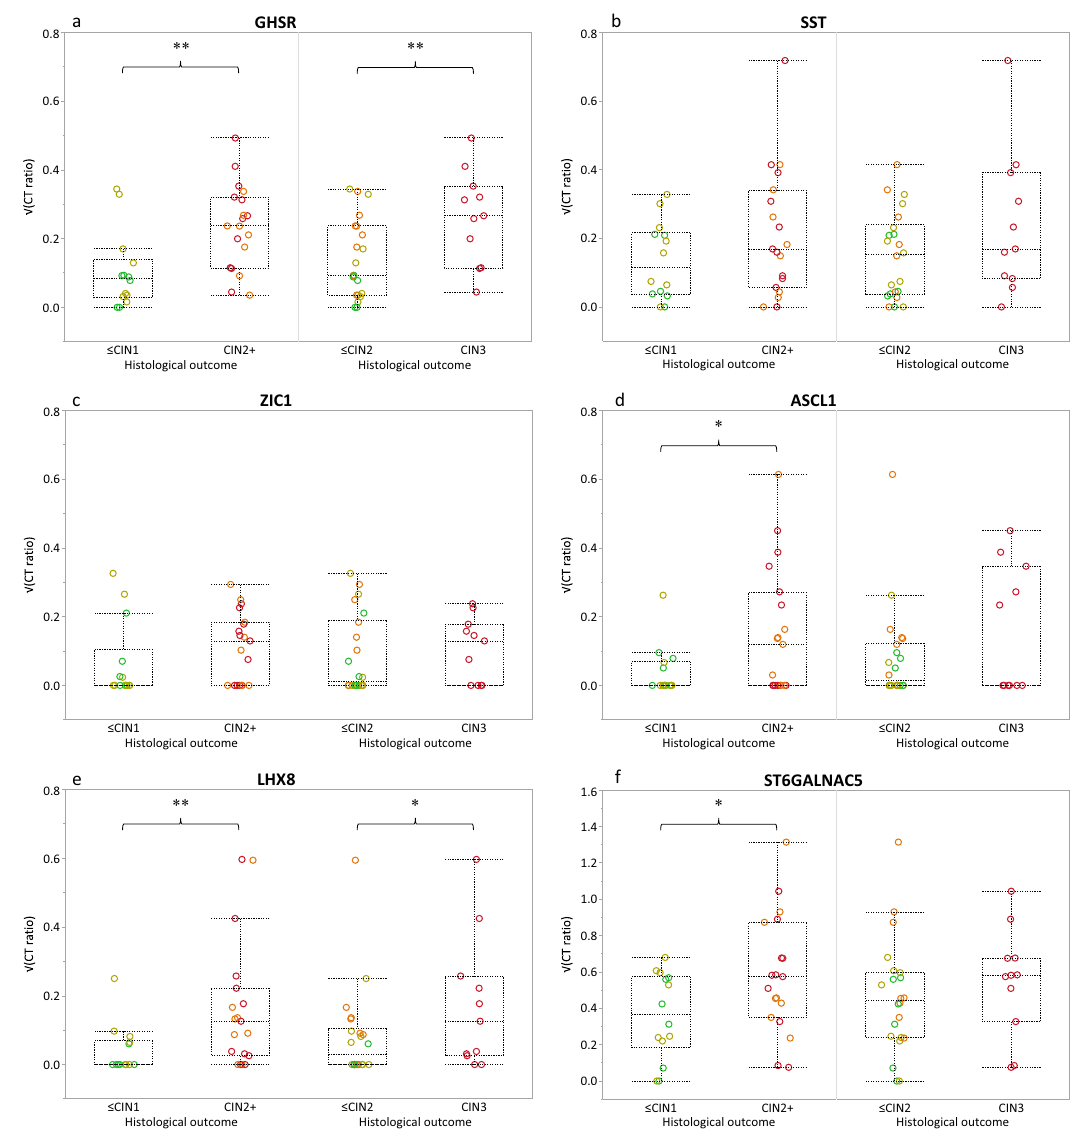
Figure 4. Difference in methylation ratios (square root transformed; y-axis) for normal/low-grade and high- grade cervical disease according to histological outcome (CIN2 + and CIN3; x-axis); normal/CIN0 (green circles, n = 6), CIN1 (yellow circles, n = 8), CIN2 (orange circles, n = 8), and CIN3 (red circles, n = 11). Box-plots indicate median methylation levels of ( a ) GHSR , ( b ) SST , ( c ) ZIC1 , ( d ) ASCL1 , ( e ) LHX8 , and ( f ) ST6GALNAC5 and according interquartile ranges (25th and 75th percentile). P-values (Mann Whitney U-test) indicated by a double asterisk mean that the null hypothesis (H0) is rejected (p ≤ 0.05) and that the median square root transformed methylation marker ratios between normal/low-grade and high-grade cervical disease are not equal. P-values indicated by a single asterisk indicate a trend (0.05 < p ≤